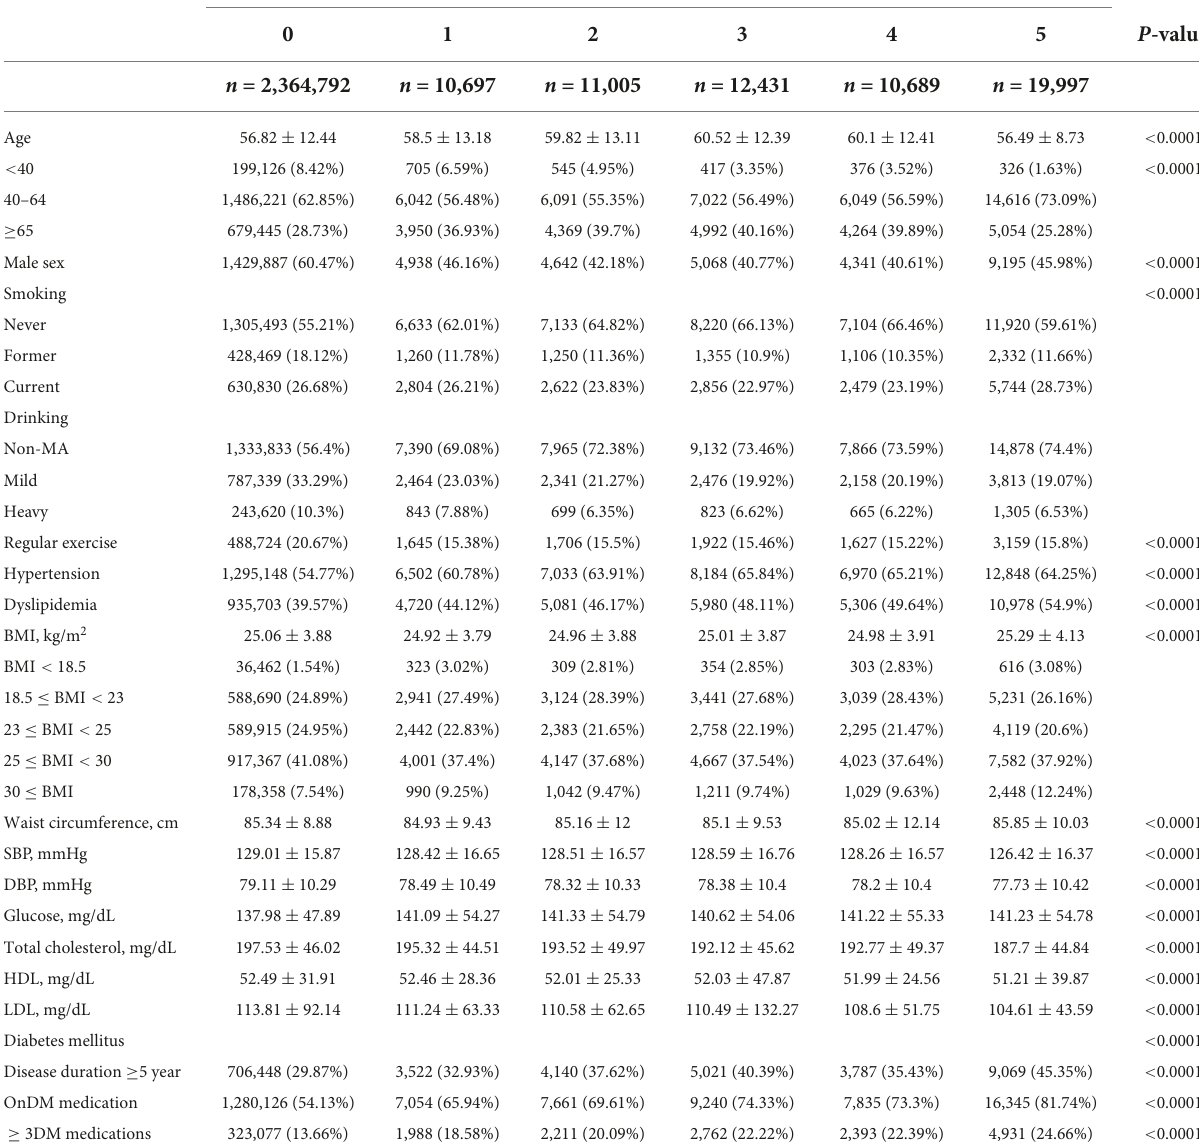
TABLE 1 Baseline characteristics of the subjects grouped by the number of times receiving medical